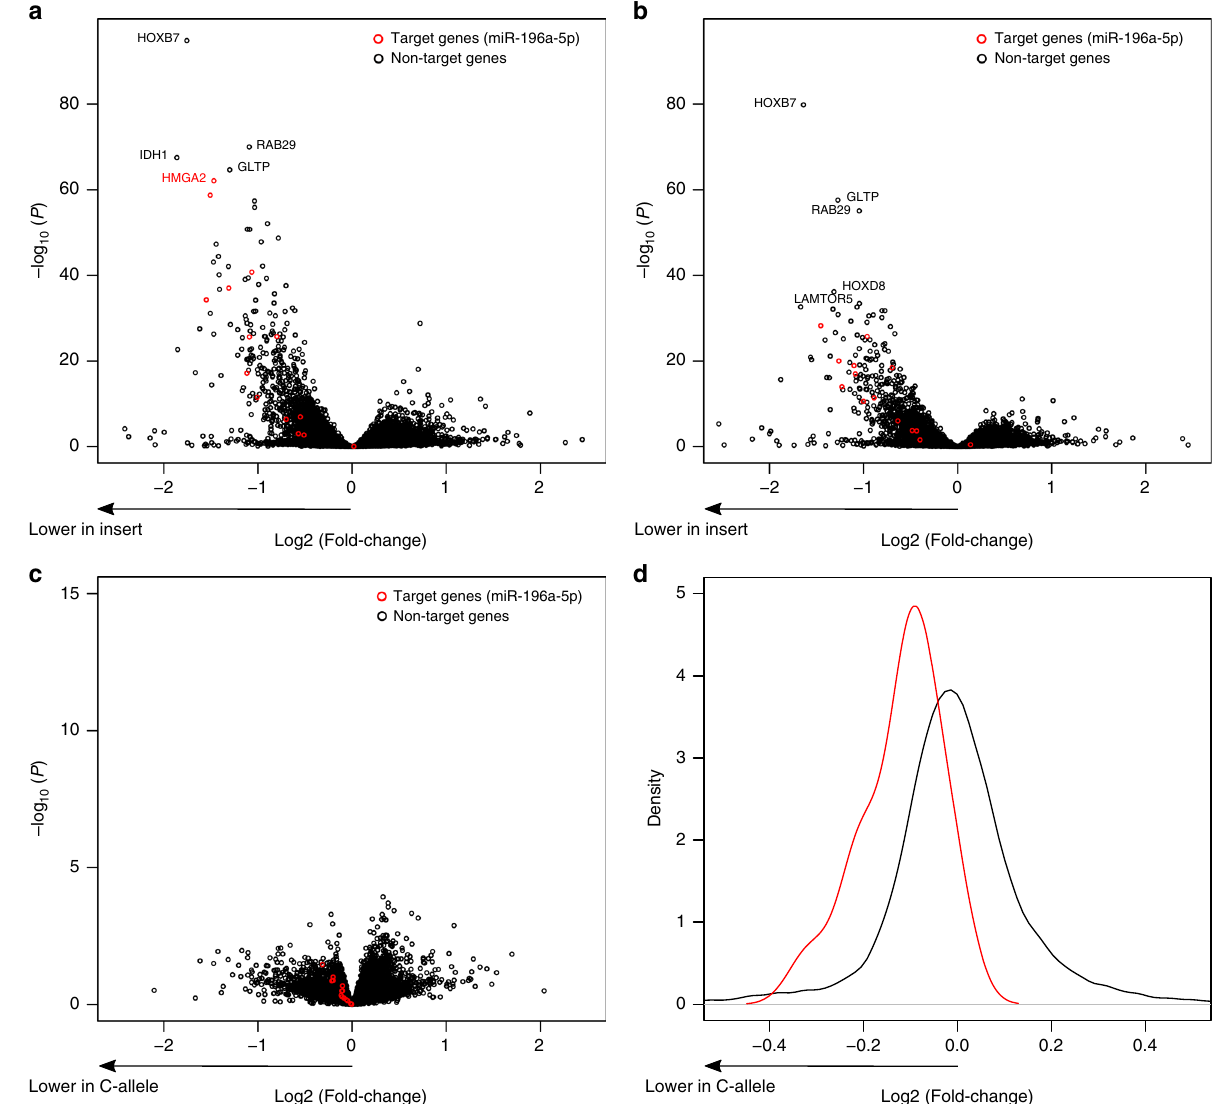
Fig. 2 Repression of miR-196a-5p target genes by MIR196A2 C-allele or T-allele inserts. a – c Volcano plot shown for all pair-wise comparisons of cells with MIR196A2 C-allele or T-allele inserts and empty vector controls. In each comparison, red colored dots indicate the fourteen miR-196a-5p target genes. a C- allele compared with empty vector insert, ( b ) T-allele compared with empty vector insert, and ( c ) C-allele compared with T-allele. Negative log2-fold values re fl ect downregulation with miRNA insert and in a and b , whereas negative log2-fold values re fl ect downregulation of the C-allele in c . d Distribution of log2 fold-change values derived from the comparison of C-allele and T-allele transfected cells (negative log2 fold represents downregulation of the C- allele). The red and black curves represents the density distribution for the fourteen high-con fi dence miR-196a-5p target genes and other non-targets, respectively. The direction of effect is indicated below the x -axis by an arrow. Source data are provided as a Source Data fi